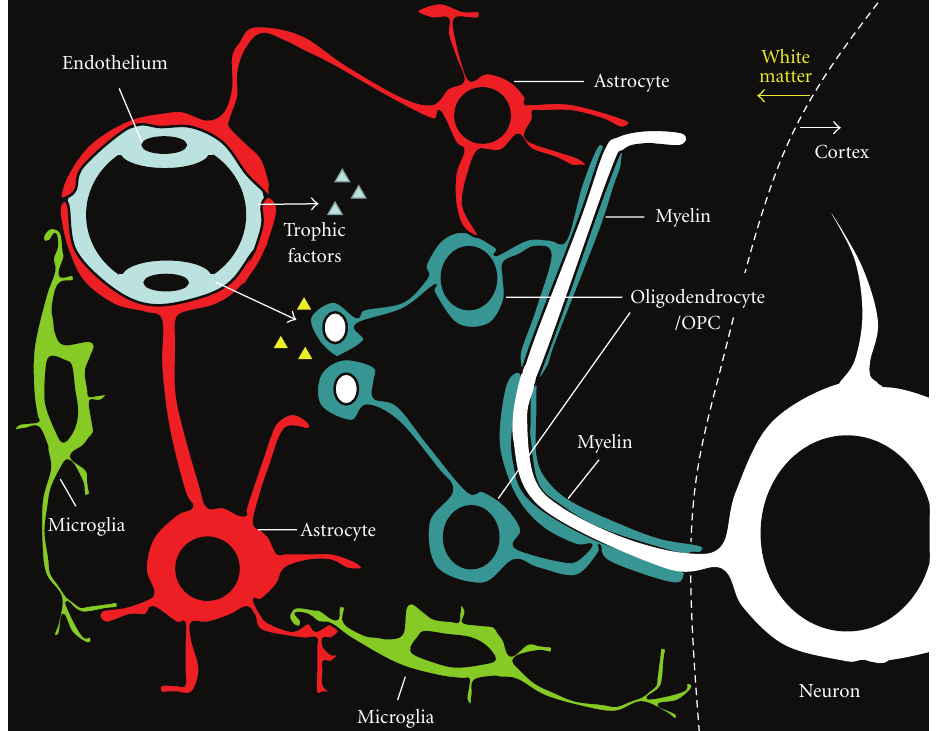
Figure 4: A schematic illustration of oligovascular niche. In the “oligovascular niche,” crosstalk between endothelial cells and oligodendrocytes mediated by an exchange of soluble signals (e.g., trophic factors or chemical messengers) might play an important role in sustaining oligodendrocyte homeostasis and WM integrity. Since oxidative stress and inflammation caused by cerebral hypoperfusion would be detrimental for this niche, maintenance of white matter integrity or oligovascular protection could be achieved by proangiogenic, antioxidative, and anti-inflammatory interventions. OPC: oligodendrocyte precursor